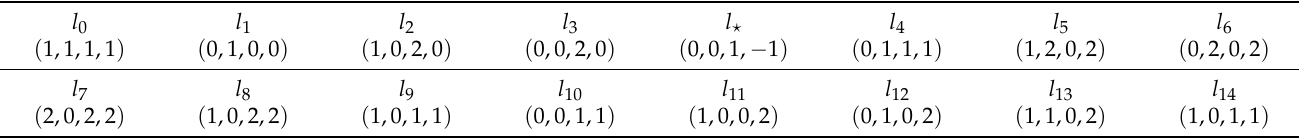
Table 1. ( λ i , ψ i + 1 , ∆ i + 1 ( B ) , p 1 ) for the arcs of S 0